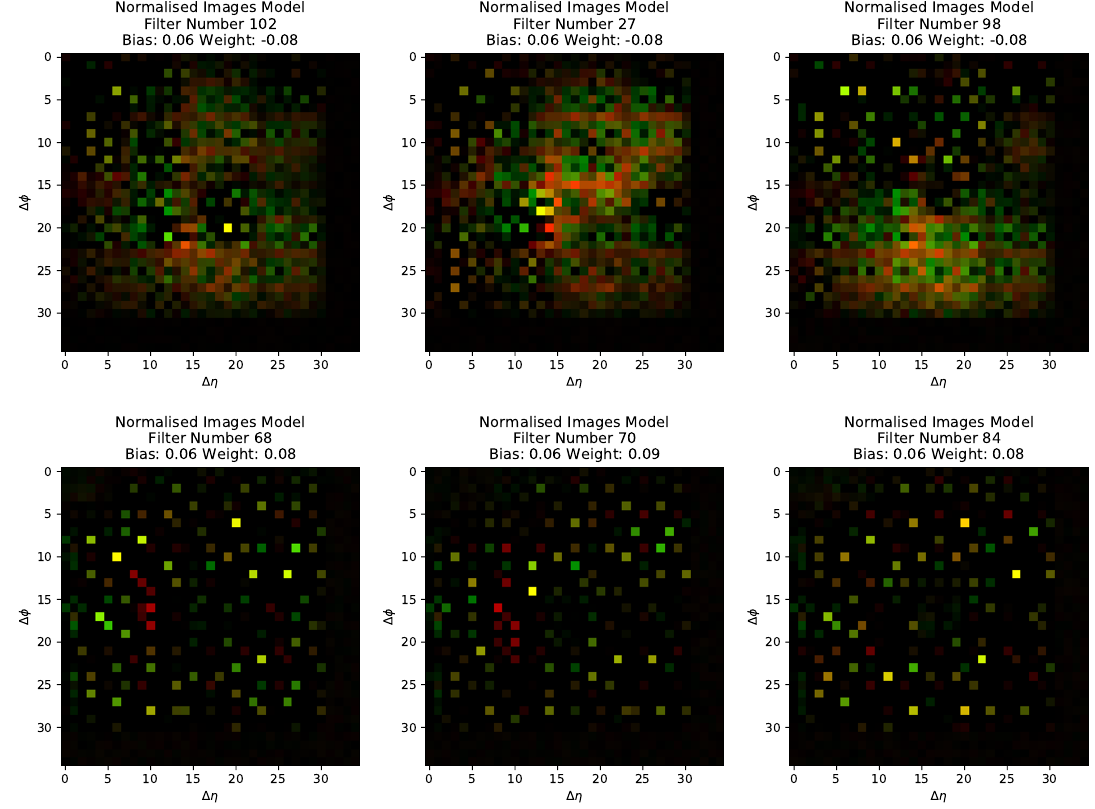
Figure 18 . The most discriminative patterns of the normalised images. Red represents the transverse momentum channel, green the multiplicity channel. Brighter pixels represent the pattern that maximised the activation of the respective filter. Since the top (bottom) filters have a negative (positive) weight, they are being triggered by vacuum (medium) sample